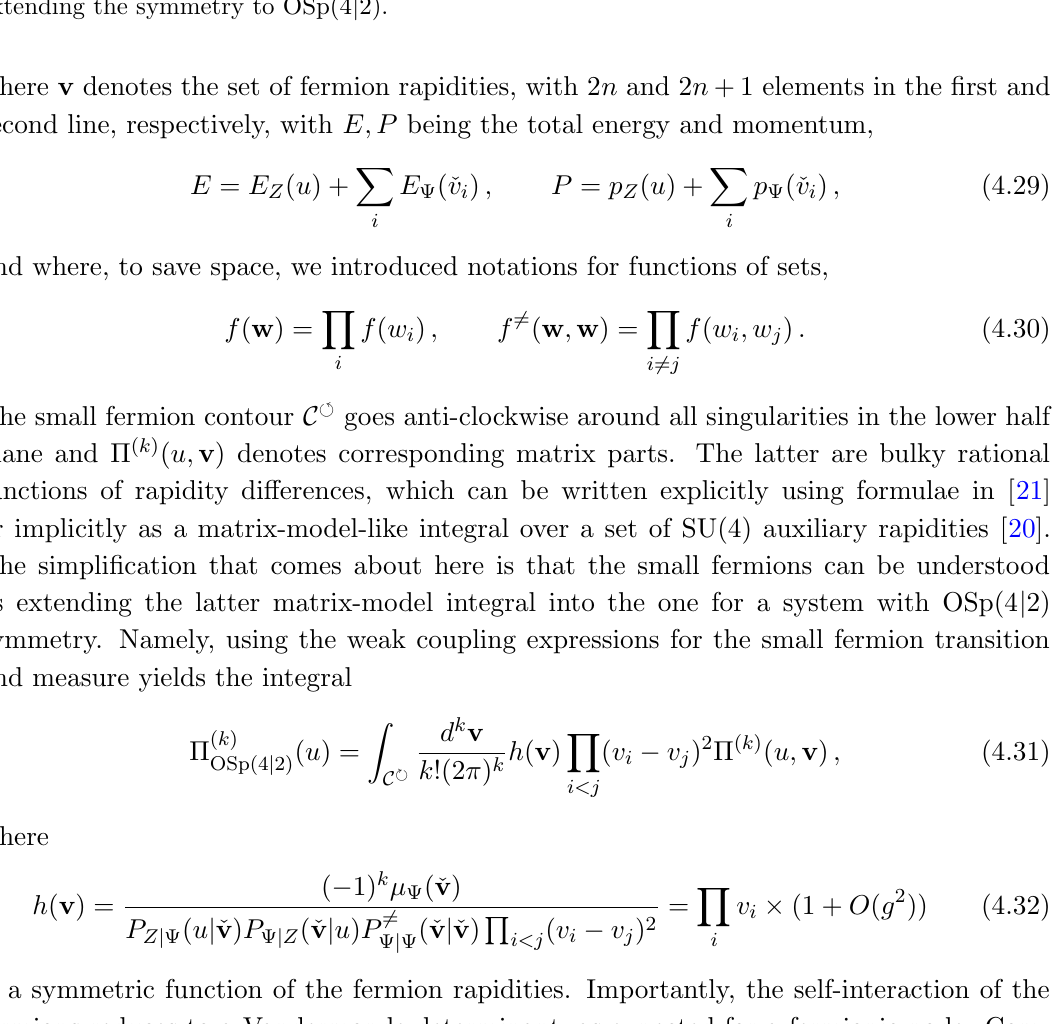
Figure 8 . Dynkin diagrams encoding the matrix integral for descendents of a spinon Z (cid:24) (cid:30) and anti-spinon (cid:22) Z (cid:24) . The top part is the Dynkin diagram for the SU(4) degrees of freedom with the labels indicating the numbers of corresponding auxiliary roots. They couple to the matter content represented by the bottom part. The small fermions are represented by the crossed nodes and the spinons by the boxes. The excitations numbers are chosen such that the overall charge matches the quantum number of (cid:30) . We can view the small fermions as associated to a fermionic generator and extending the symmetry to OSp(4 j